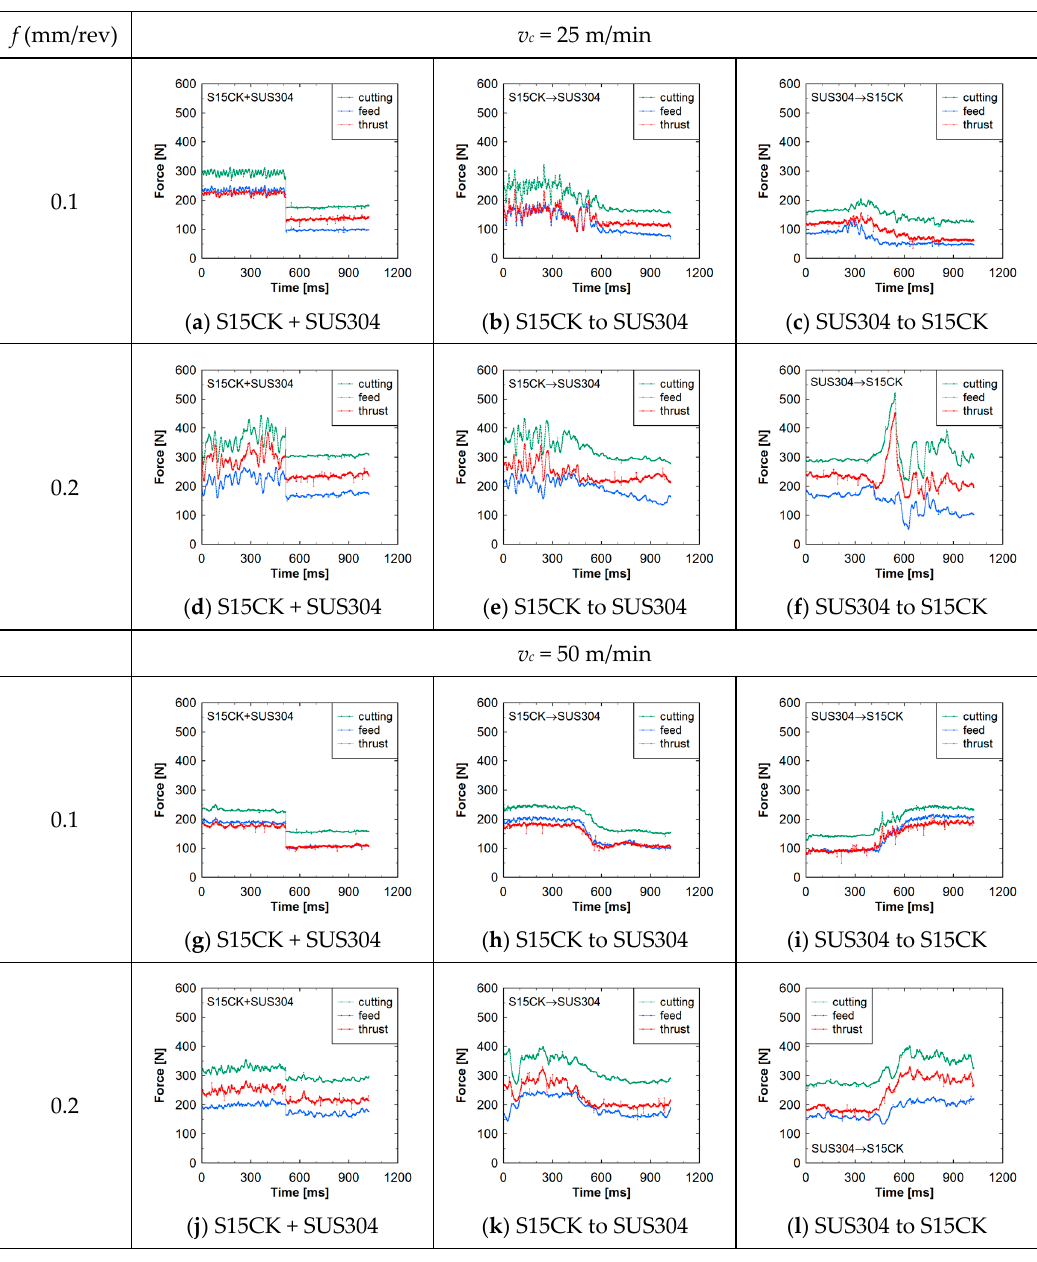
Figure 4. Machining forces underlying SU − SC.